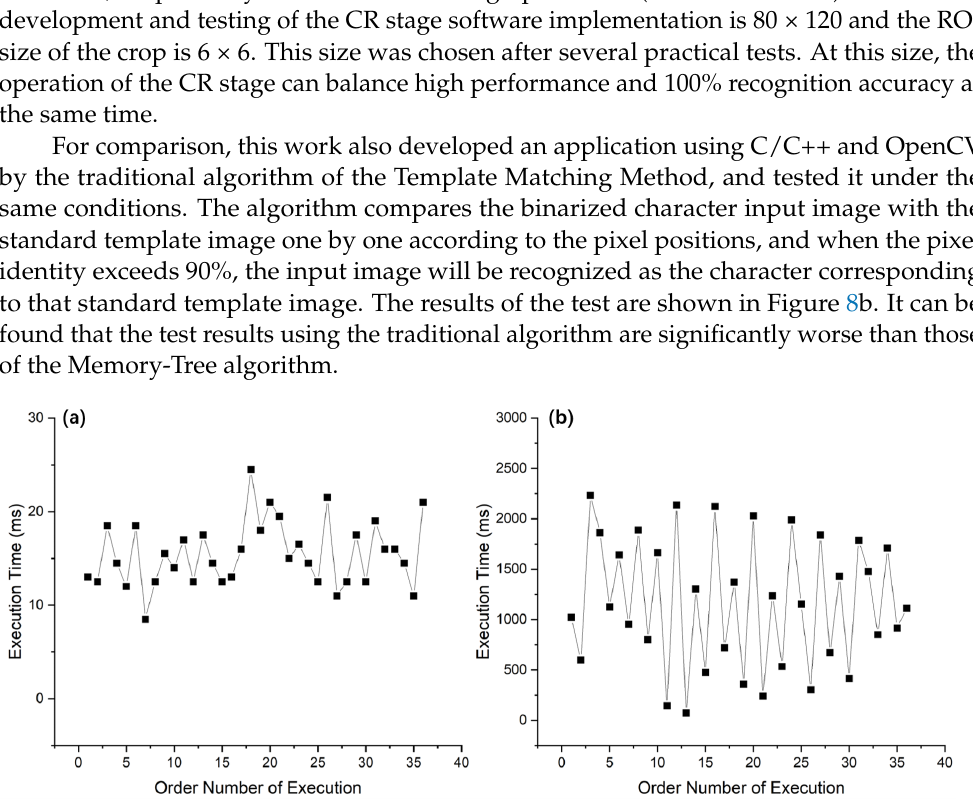
Figure 8. Execution time of the CR stage using ( a ) Memory-Tree algorithm optimization and ( b ) the Traditional Template Matching Method algorithm in software